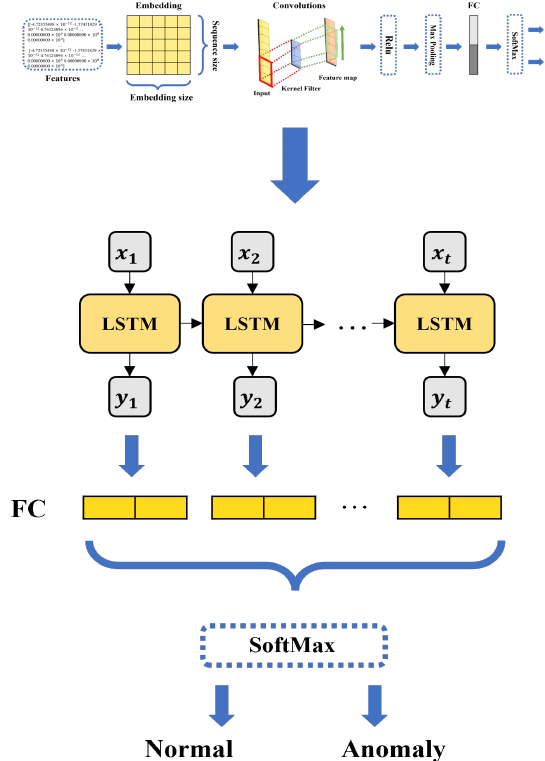
Figure 5. CNN1D-LSTM-based log anomaly detection model